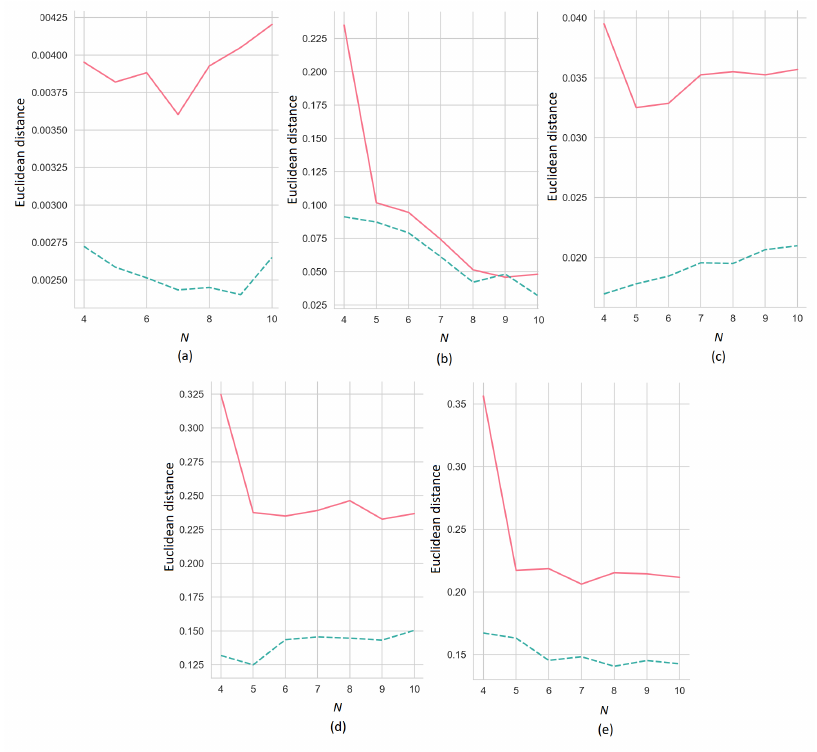
Figure 13. Euclidean distances between ER-SHAP-RF and SHAP as functions of N for t = 2 (the solid line) and 3 (the dashed line) for five datasets depicted in corresponding Figure 4a–e and trained